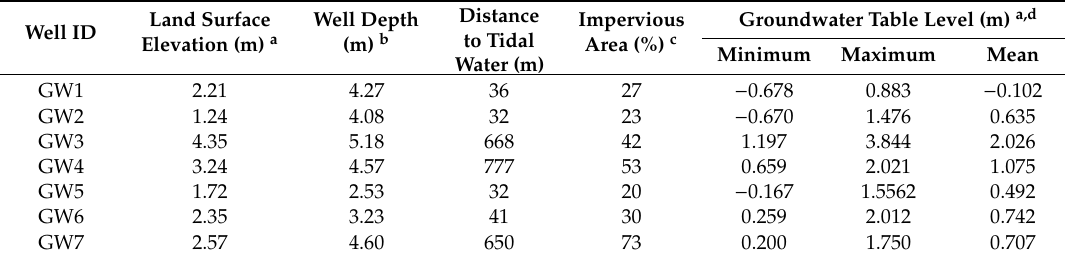
Table 1. Groundwater table monitoring well details.